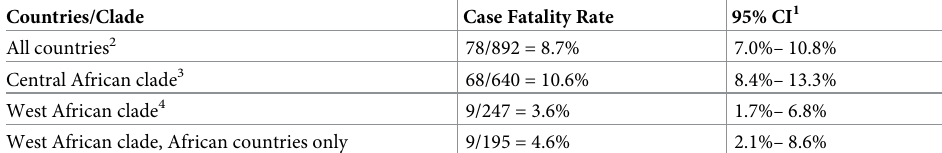
Table 3. Pooled case fatality rate in confirmed, probable, and/or possible monkeypox cases.